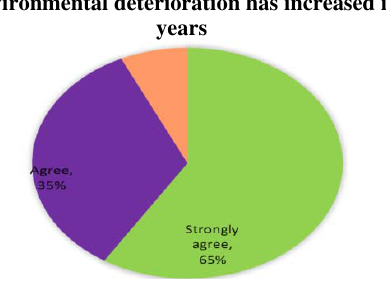
Fig. 1. Environmental deterioration has increased in recent